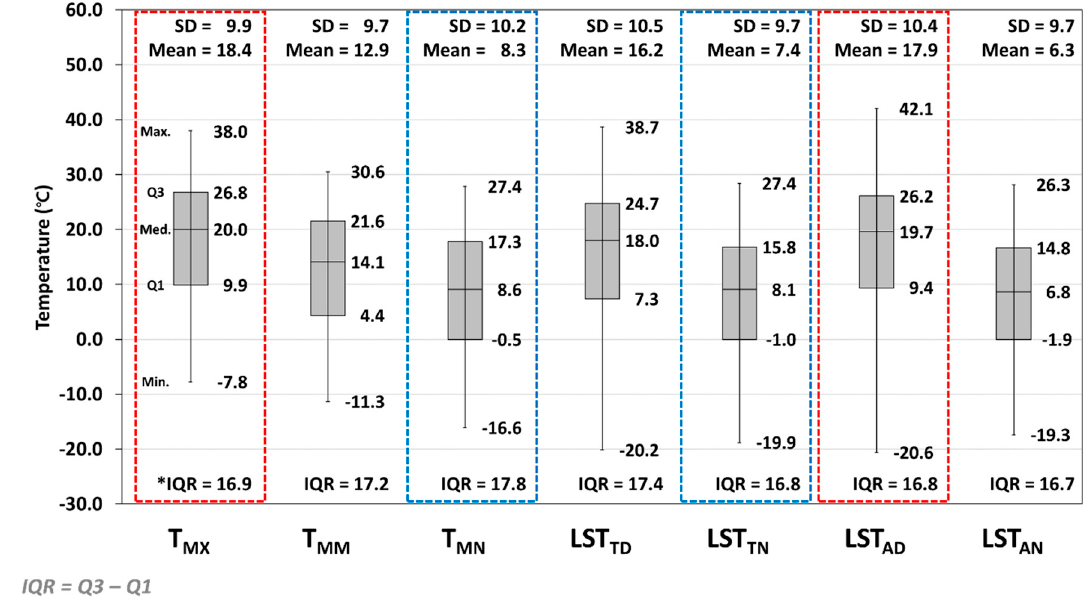
Figure 4. Boxplots of observed maximum, minimum, and mean SAT (T MX , T MM , T MN , respectively) and four land surface temperatures (LSTs) (LST TD , LST TN , LST AD , LST AN ) for 79 ASOS stations from 2008 to 2018. Among the four LST datasets, the average for LST TD was the highest, similar to the T MX , and the LST TN average was the closest to the T MN . IQR: interquartile range.